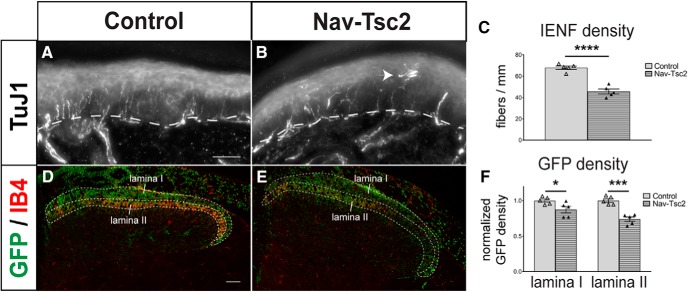
Fiber innervation is reduced in both central and peripheral targets of DRG neurons in Nav-Tsc2 mice. A, B, Projection of a z-stack of hindpaw glabrous skin labeled with TuJ1. Arrowhead shows aberrant fiber morphology in Nav-Tsc2 mice. Dotted line denotes epidermal-dermal border. Scale bar: 50 µm. C, Number of TuJ1-positive fibers crossing the epidermal-dermal border were counted in control and Nav-Tsc2 mice; N = 5. D, E, Confocal micrographs of Rosa-GFP reporter in control and Nav-Tsc2 lumbar spinal cord transverse sections labeled with IB4. Laminas I and II used for quantification are outlined. Scale bar: 50 µm. F, Normalized area fraction of GFP signal in Laminas I and II; N = 5. Individual animals plotted with mean ± SEM; *p < 0.05, ***p < 0.001, ****p < 0.0001.